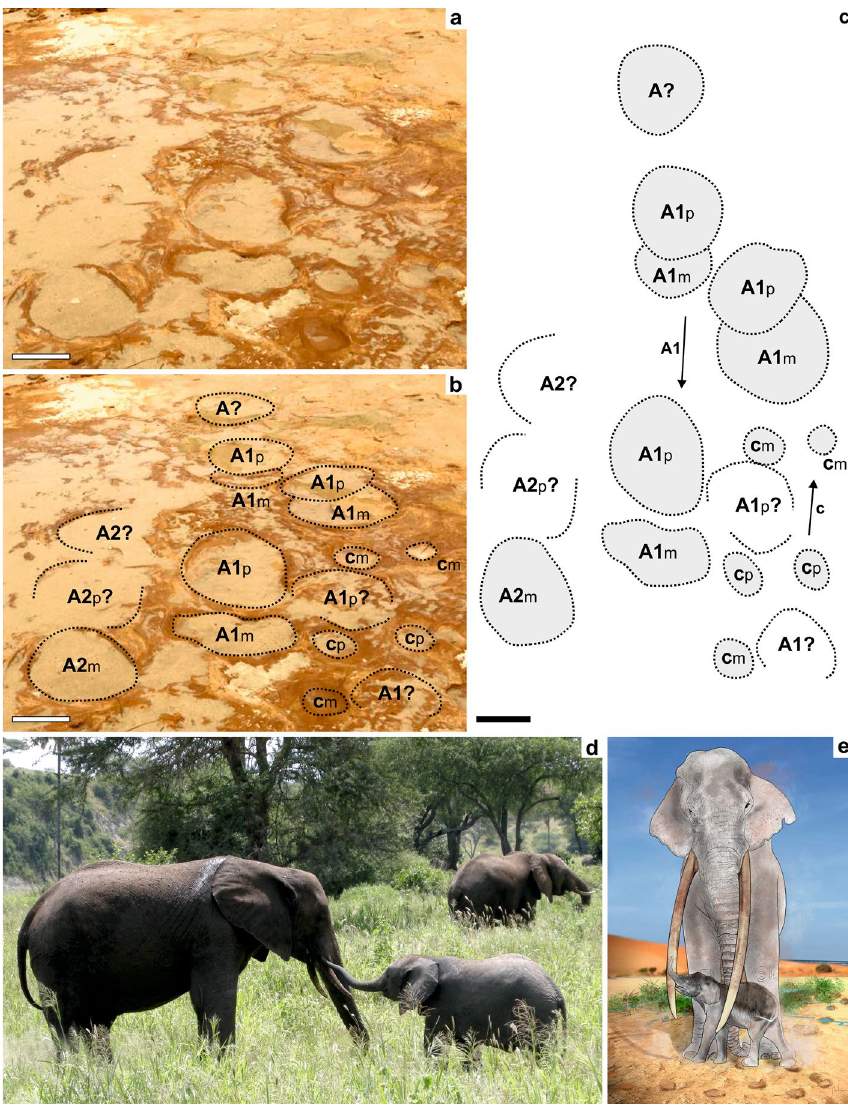
Figure 7. Ichnological evidence and reconstruction of Palaeoloxodon antiquus social interactions deduced from the MTS. ( a – c ) Two adult (presumably female) ‘A1 & A2’ and one juvenile trackway ‘c’ showing convergence (the toe impressions indicate opposite orientation of movement); note overstepping of pes over manus in the main adult trackways that is not seen in the smaller tracks, in this case because the small juvenile may have stopped just after the larger animal slowly passed by (interpretation in c ). ( d ) Example of a young mother- newborn L . africana interaction. ( e ) Reconstitution of mother-newborn interaction in the MTS (artwork of J.